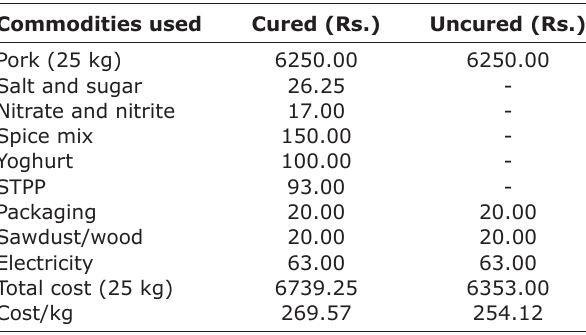
Table-6: Economics of Vawksa rep (smoked pork